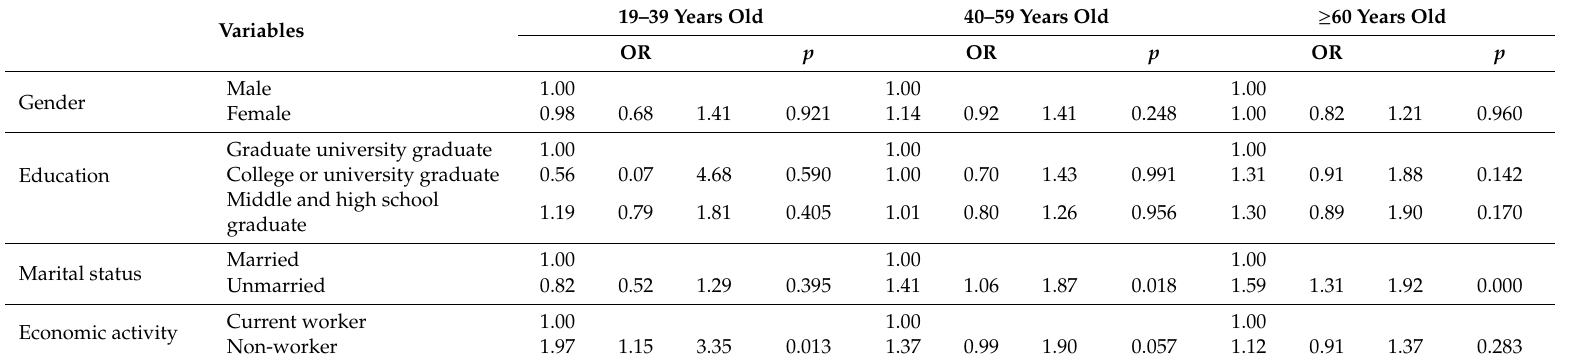
Table 4. Regression analysis of the factors that a ff ect unmet medical needs according to age